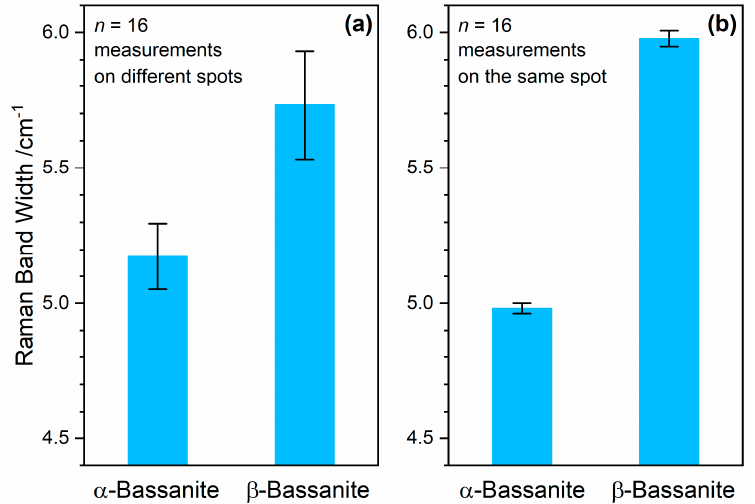
Figure 13. Band widths (full widths at half maximum) of the ν 1 mode of α -bassanite and β -bassanite from 16 measurements ( a ) performed at different spots and ( b ) repeated at the same spot of powder samples. The bar heights represent mean values and the error bars represent standard deviations.